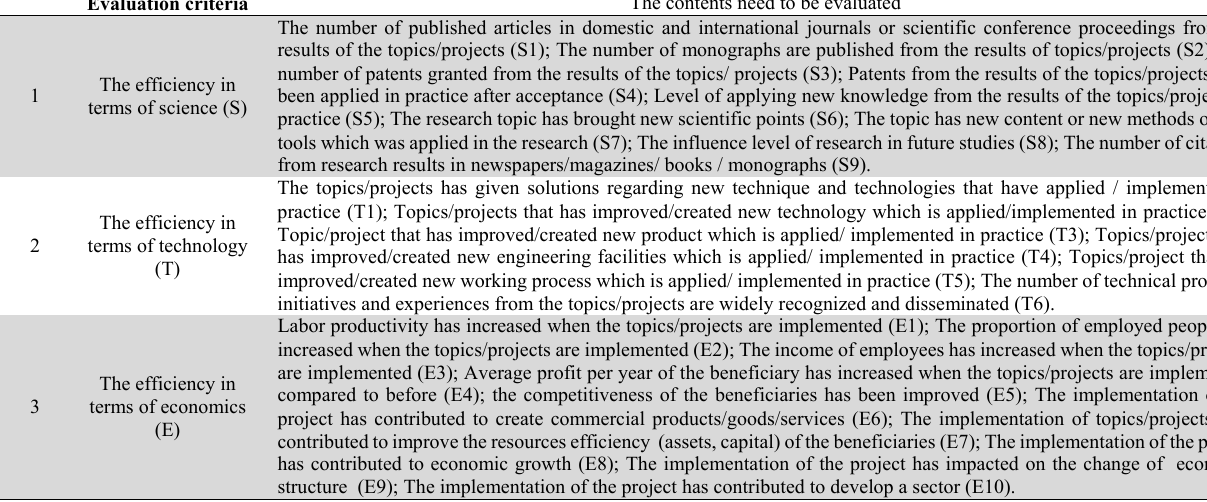
The results of contents need to be evaluated in each criterion Evaluation